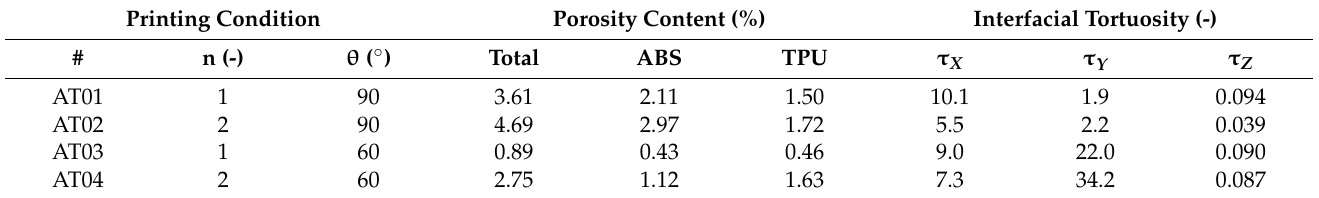
Table 1. Microstructural attributes derived from image analysis of X-ray micro-tomography images. Printing Condition Porosity Content (%) Interfacial Tortuosity (-) θ ( ◦ ) Total ABS TPU τ X τ Y τ Z 90 60 0.89